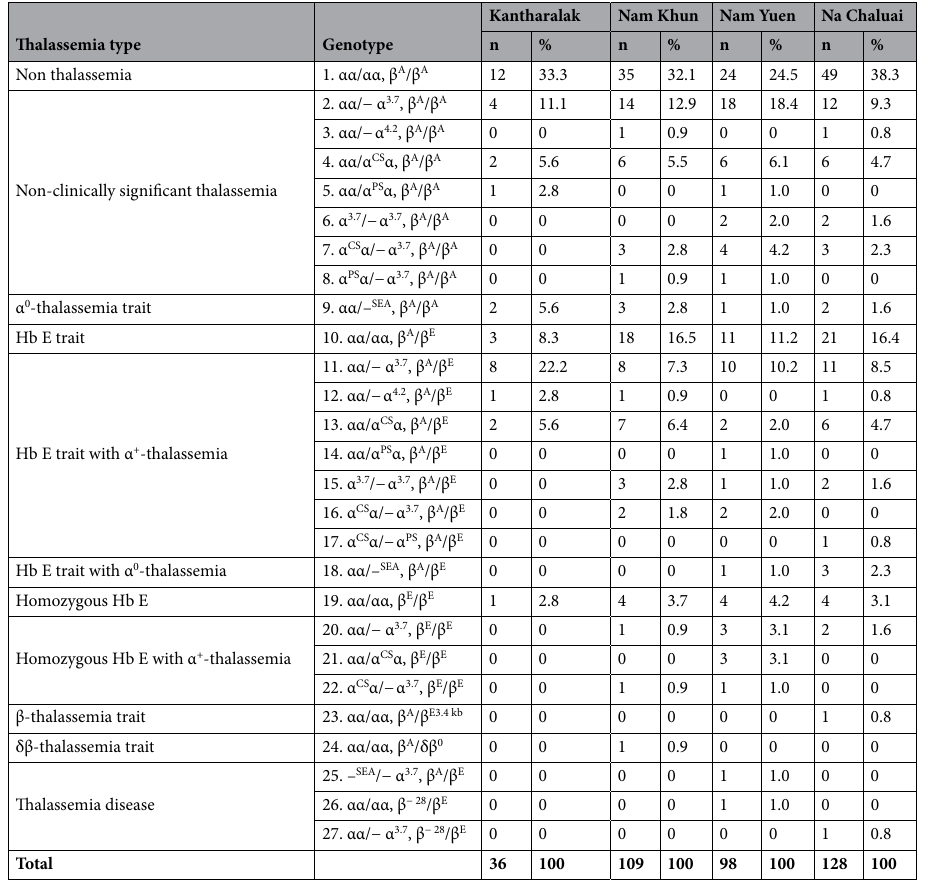
Table 1. Globin genotypes of 371 subjects inhabiting at the border region of Thailand, Lao PDR and